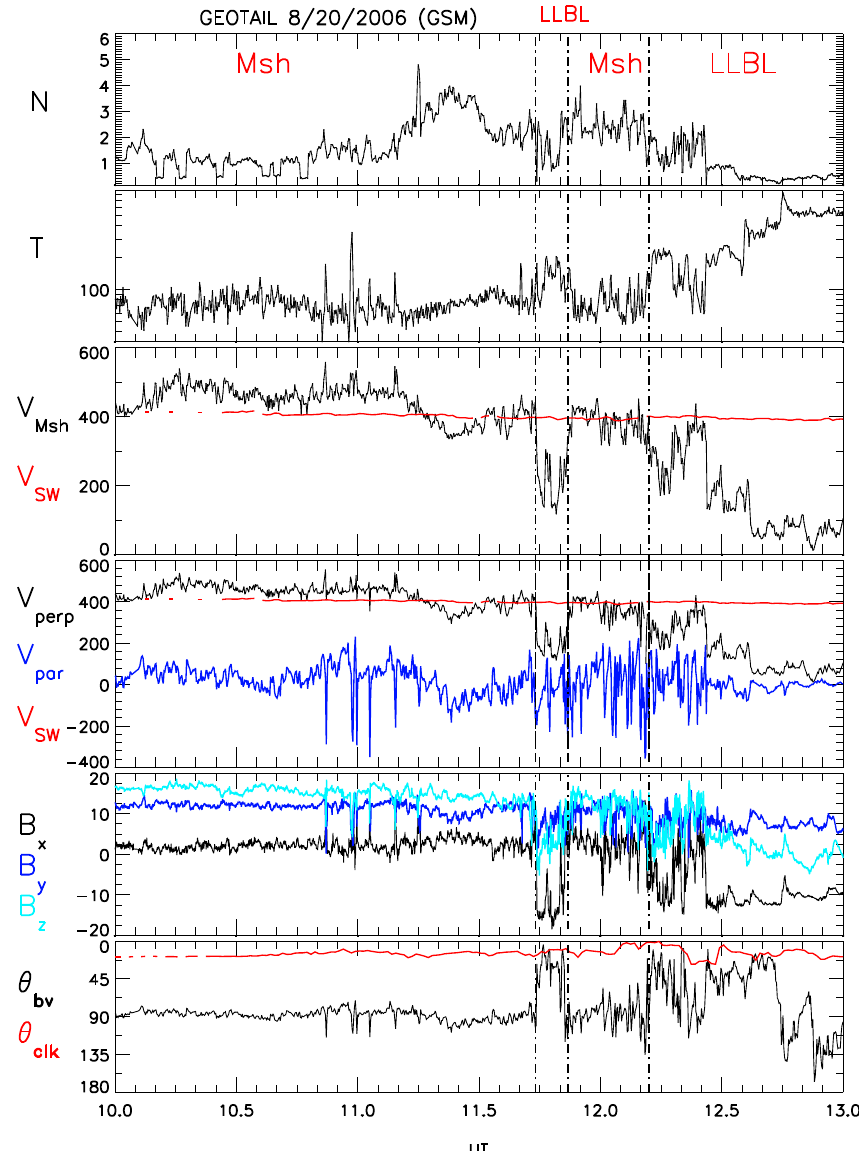
Fig. 4. Event on 20 August 2006. Same format as in Fig. 3. Notice the parameter θ bv , which is plotted at the bottom with the clock angle of the IMF θ clk . θ bv is practically constant at 90 ◦ for 1.75h in the magnetosheath leading up to the first magnetopause crossing at